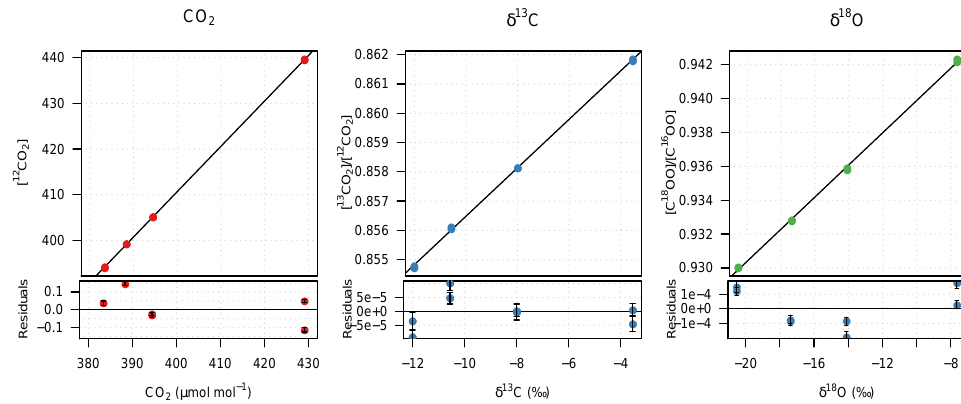
Fig. 5. Instrument response versus assigned values of the four primary standards as determined on 25 May 2012. The solid lines are weighted linear least squares fits to the data. The residuals from the fit are shown in the lower panels with the error bars representing the standard error of the mean. The ordinate represents the natural abundance weighted isotopologue ratios as retrieved by the spectrometer.